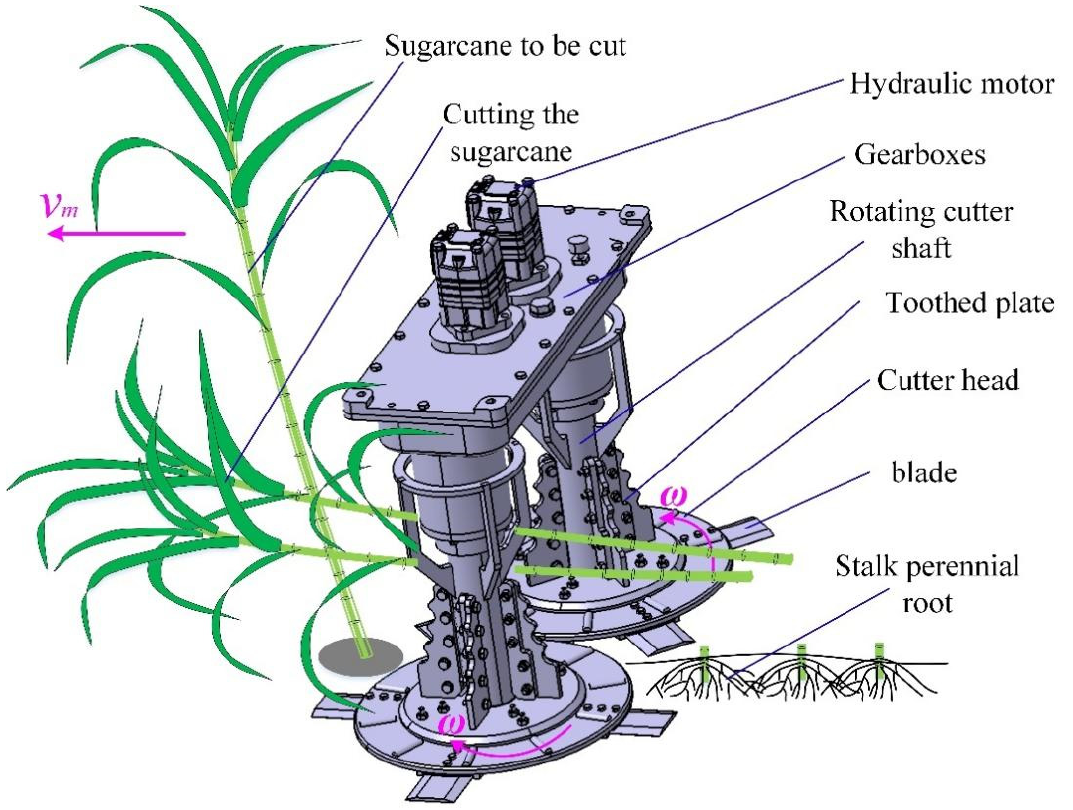
Figure 1. Composition and working principle of the double disc-cutter.